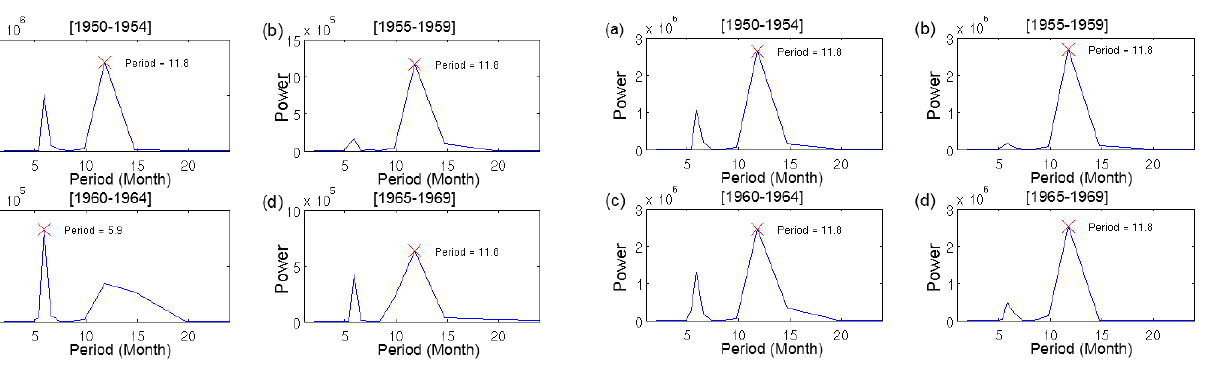
Fig. 20. Periodicities around 1960 in Nakuru estimated from the representative time series of the harmonics. (a) shows the periodic- ities between 1950 and 1954, (b) between 1955 and 1959, (c) be- tween 1960 and 1964, and (d) between 1965 and 1969. The red cross mark means the major periodicity in each time region.